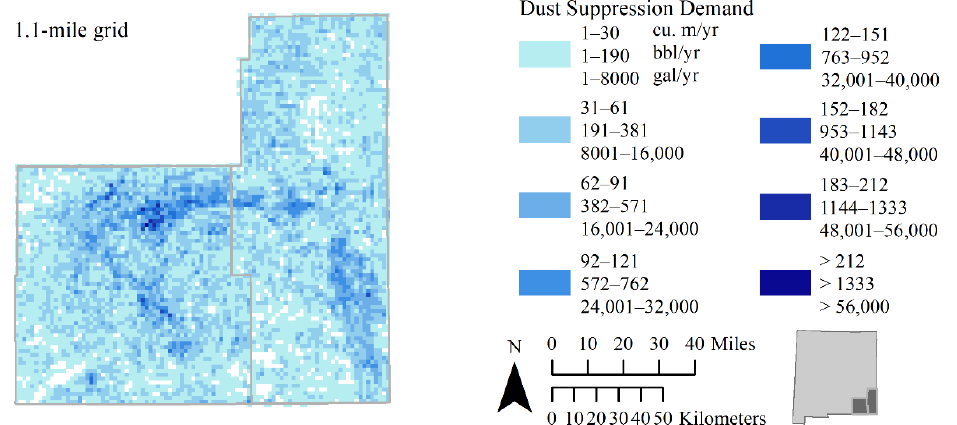
Figure 8. Estimated water demand for dust suppression based on the length of unpaved roads within each grid cell.